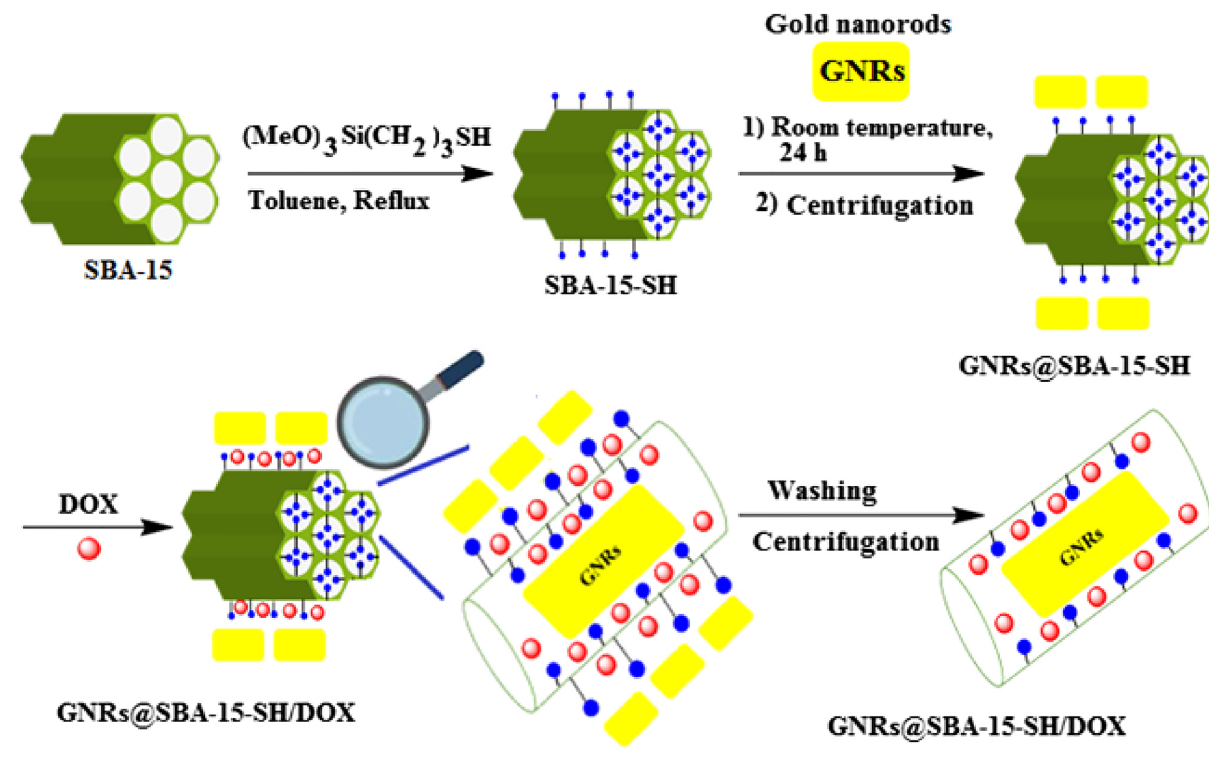
Figure 1: Schematic illustration the synthesis of the GNRs@SBA-15-SH/DOX